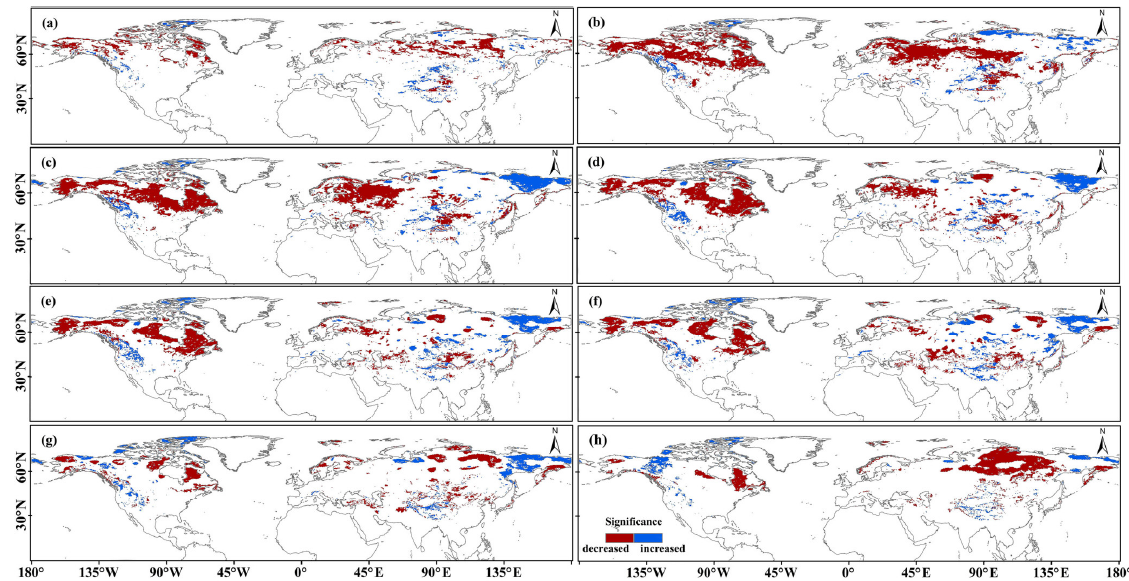
Figure 4. Significance patterns ( p < 0.05) of monthly average SD in the NH. ( a – h ) correspond to